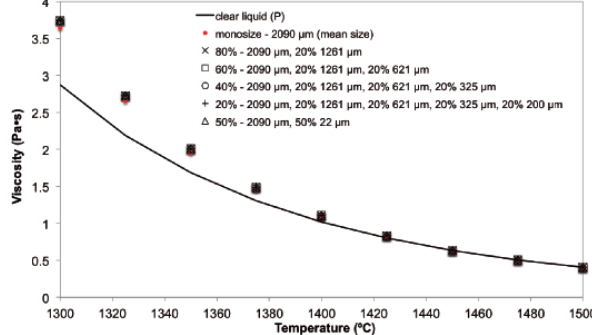
Fig. 6: Sensitivity to the parameters in Veytsman’s model.